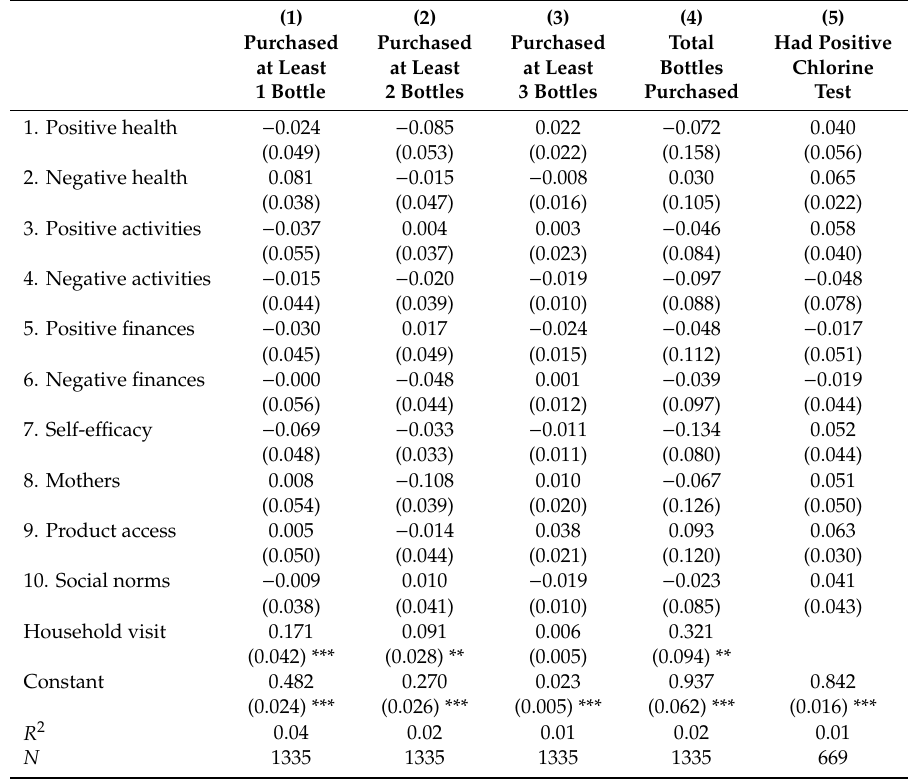
Table 5. Impact of individual constructs.